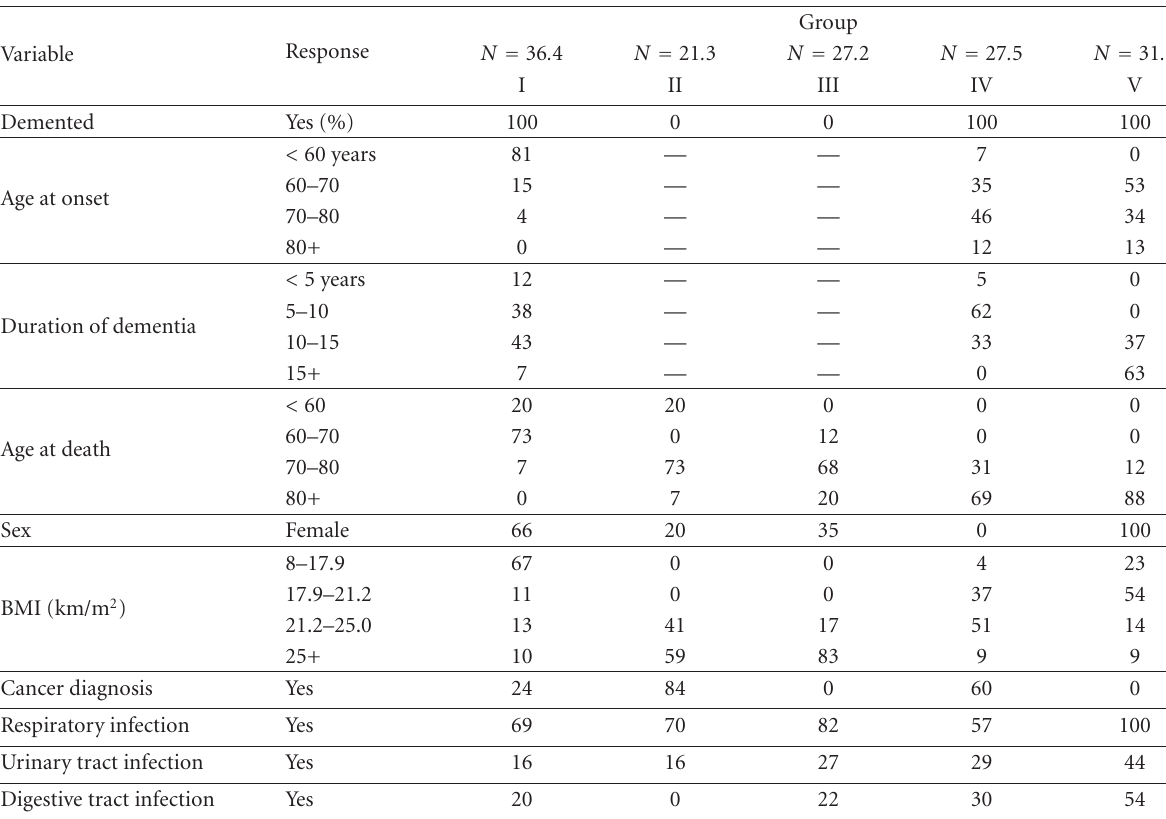
Table 4. Clinical variable frequencies for each group. Each model-based group is defined by the probabilities of being demented & probabilities of response for the other variables, that is, the model λ parameters.